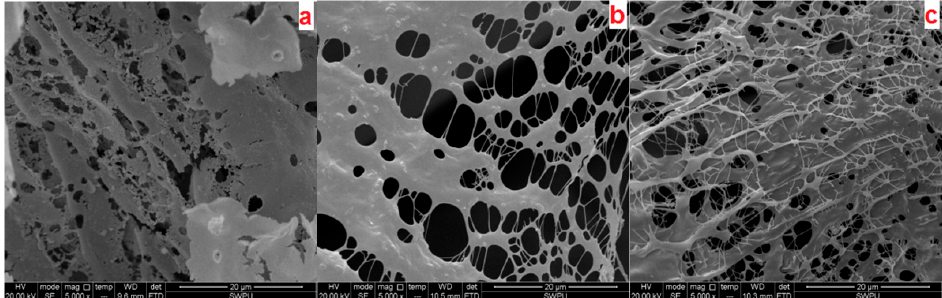
Figure 12. SEM of 0.15 wt.% drag reducers in 10 × 10 4 mg/L aqueous NaCl solution: ( a ) PHWAM-1, ( b ) PHWAM-2, and ( c ) PHWAM-3.